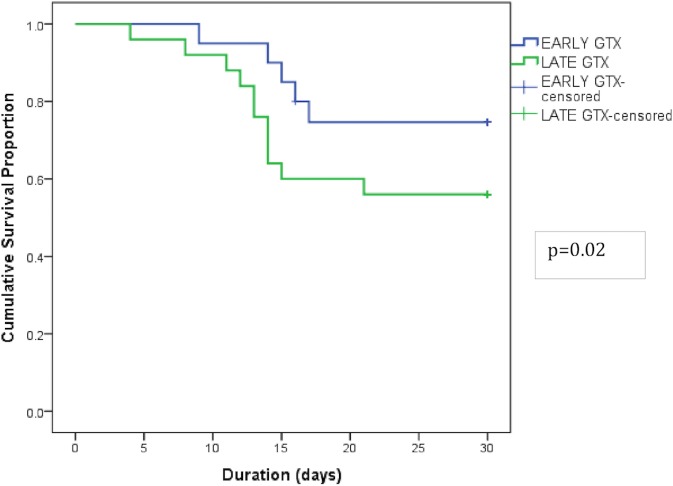
Kaplan Meier survival curves for infectious episodes (IEs) due to MDROs given GTX before 7 days (n = 20) versus those given GTX ≥7 days (n = 27).